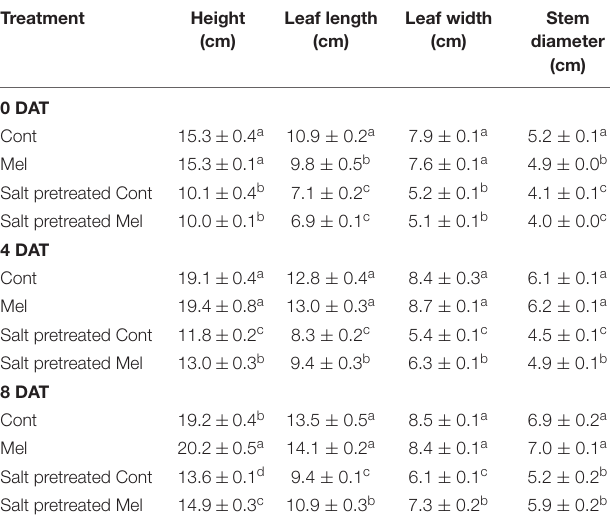
TABLE 1 | The Effect of melatonin with/without salt stress on growth parameters in green mustard seedlings.